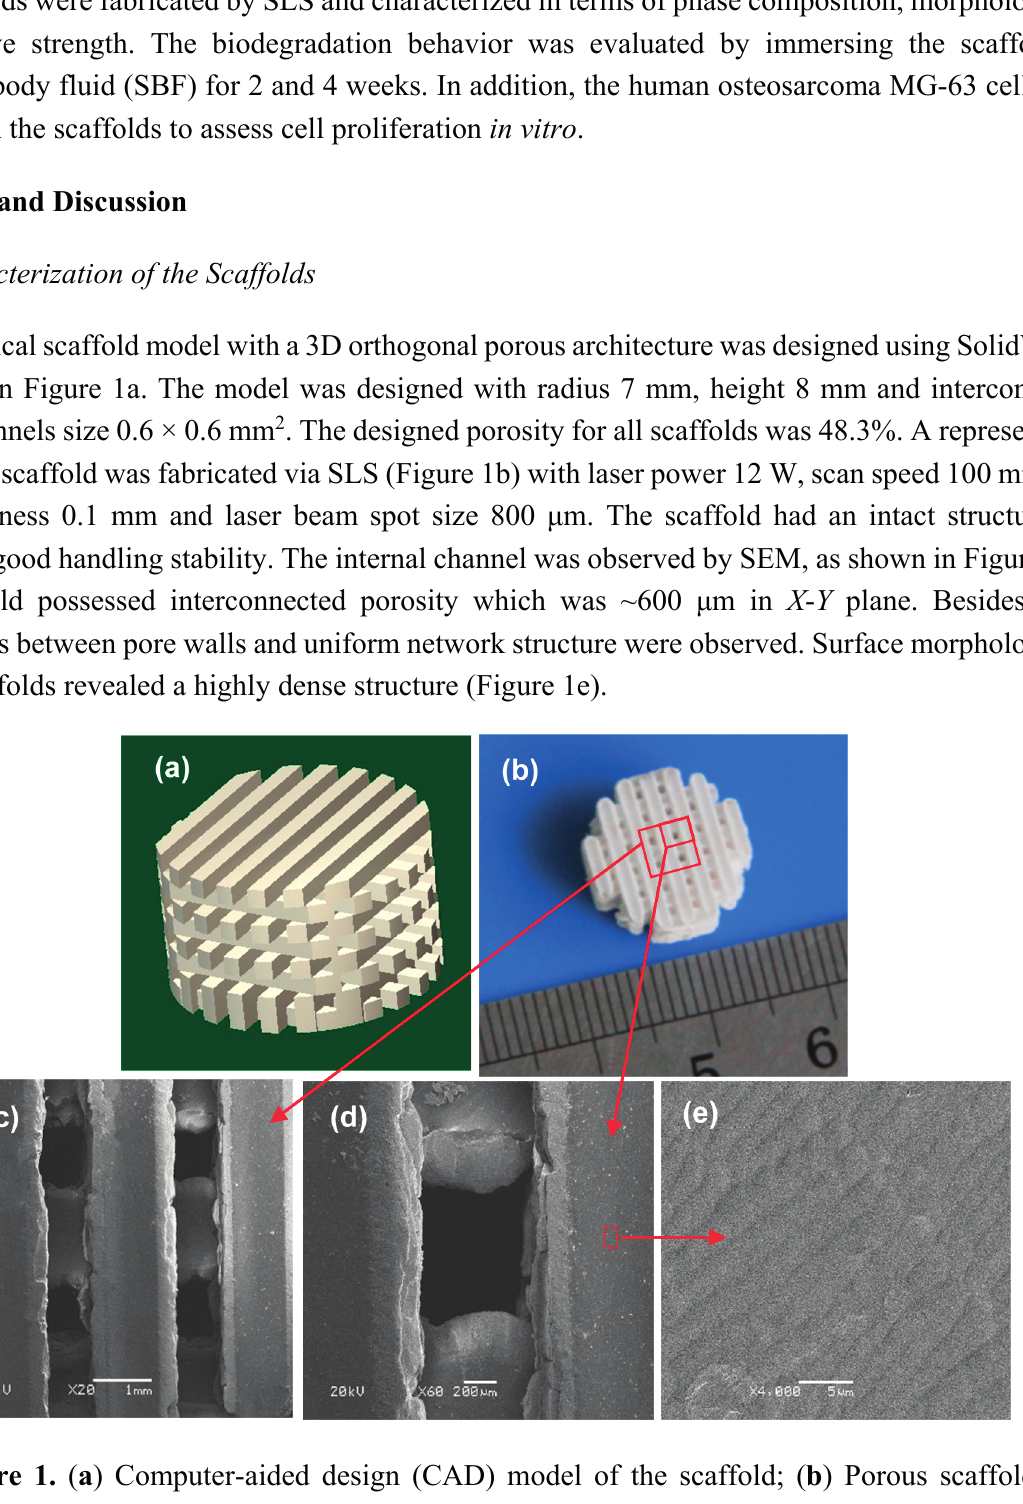
Figure 1. ( a ) Computer-aided design (CAD) model of the scaffold; ( b ) Porous scaffold (machined into a cylinder); ( c – e ) Scanning electron microscopy (SEM) micrographs of the interconnected network